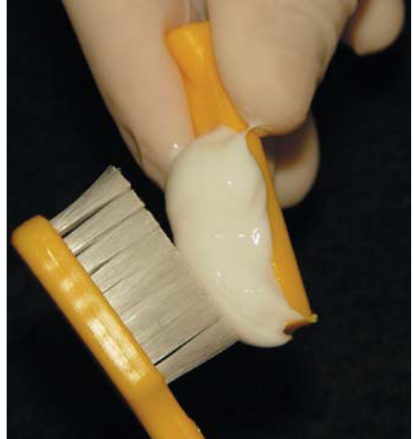
Figure 2- Cut tip handle to aid dentifrice placement onto the toothbrush bristles